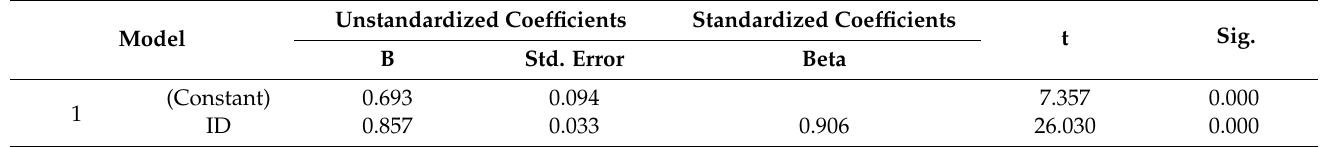
Table 5. Full Model Regression Coefficients a .